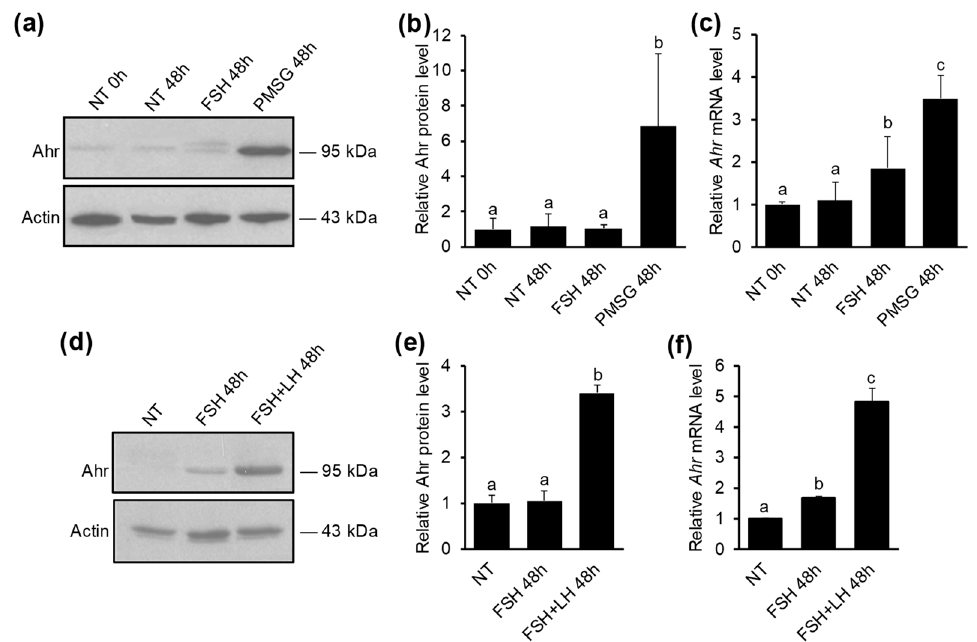
Figure 1. The effect of gonadotropins on Ahr expression in ovarian GCs in vivo. ( a ) Mice were injected once with 5 IU of PMSG, 5 IU of FSH or vehicle (NT) and lysates were collected from granulosa cells (GCs) isolated before (0 h) or 48 h later. Representative Western blot shows Ahr and actin protein levels. Specificity of Ahr antibody is shown in Supplementary Figure S1D). ( b ) Densitometry analysis of three independent experiments (mean ± SD) representing Ahr protein levels normalized to actin. ( c ) qPCR analysis of Ahr mRNA levels. ( d ) Mice were injected in total 4 times (every 12 h) with FSH (1.5 IU) or FSH (1.5 IU) + LH (1.25 IU) and lysates were collected from GCs isolated before (NT) or 48 h after initial injection. Representative Western blot shows Ahr and actin protein levels. ( e ) Densitometry analysis of three independent experiments (mean ± SD) representing Ahr protein levels normalized to actin. ( f ) qPCR analysis of Ahr mRNA levels. Bars with no common superscripts are significantly different ( p < 0.05).